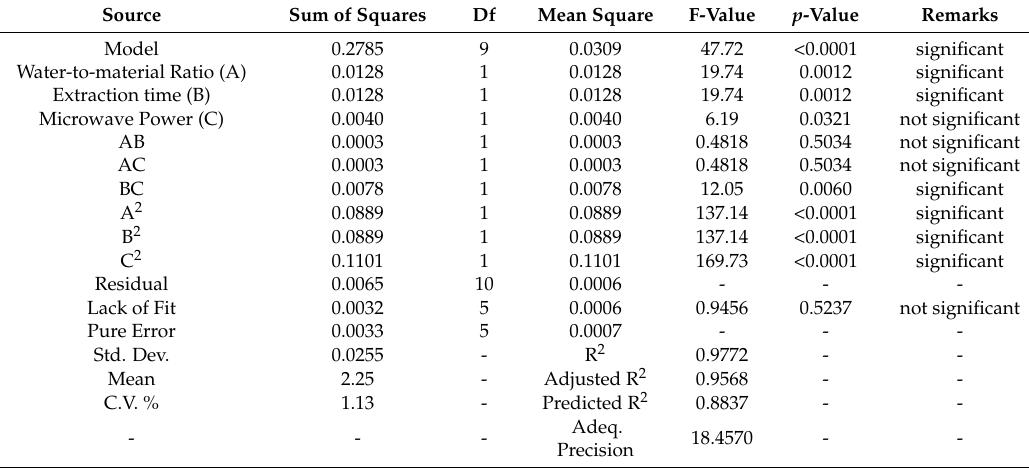
Table 2. Analysis of variance (ANOVA) for the quadratic model.